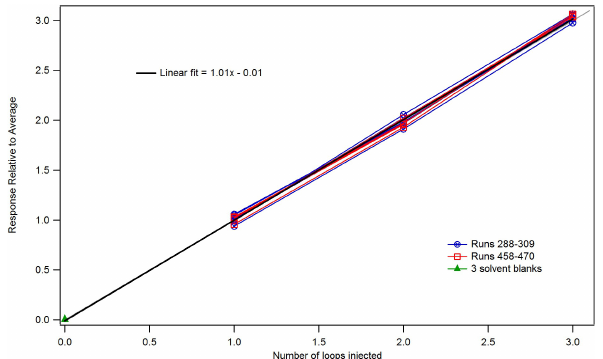
Fig. 4. Demonstration of injection of multiple loops of straight chain alkanes (C 15 to C 35 ) used as a multi-point calibration. Con- nected points are “calibration cycles” performed at two different times in the testing (blue and red, see Sect. 3.2 for further discus- sion). Average FID detector response is shown relative to the aver- age response for single loops injections interspersed between these calibrations. A linear fit (black line) is on top of the 1:1 line (gray